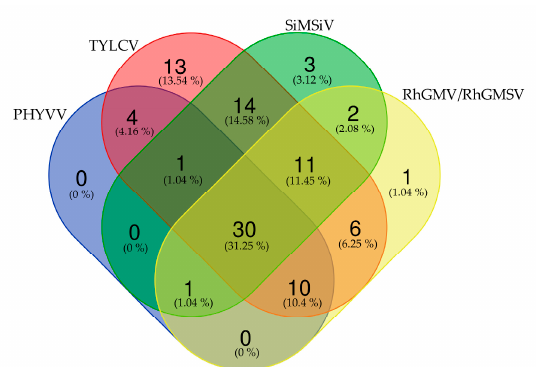
Figure 3. Venn diagram of predominant begomovirus detected. A total of 126 individual species were examined for the presence of predominant begomovirus in the five sampling regions. The number of begomovirus-positive plants (97) showing single, double, triple or quadruple infections is reported. The values are also reported in percentage in parenthesis. Virus acronyms: Pepper huasteco yellow vein virus (PHYVV), Rhynchosia golden mosaic virus , (RhGMV), Rhynchosia golden mosaic Sinaloa virus (RhGMSV), Sida mosaic Sinaloa virus (SiMSiV), Tomato yellow leaf curl virus (TYLCV).